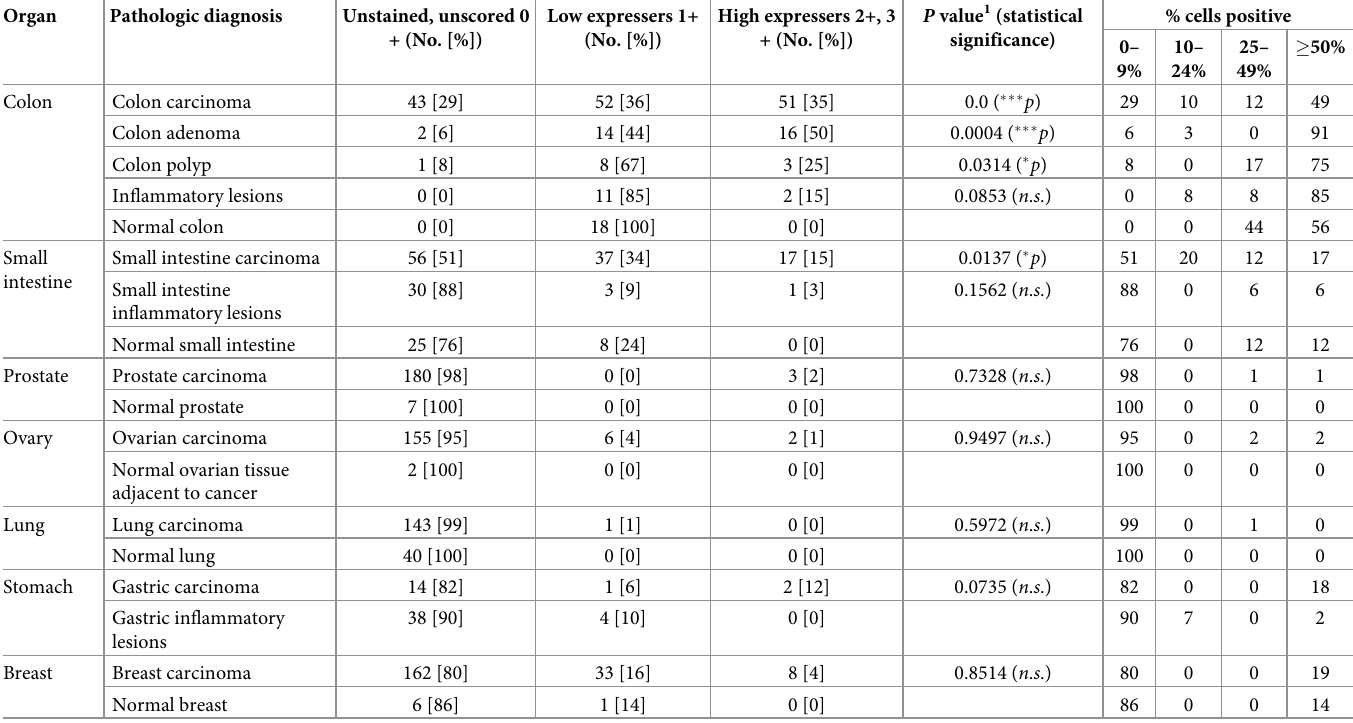
Tissues were scored as unstained (0+), low NOX1 expressers (1+), or high NOX1 expressers (2+, 3+). Percentage of tissues per score is shown in brackets. n . s ., not statistically significant. 1 The Chi-square statistical test was used to determine significant differences between the proportions of low (1+) and high expressers (2+, 3+) between malignant tissue and matched or adjacent normal